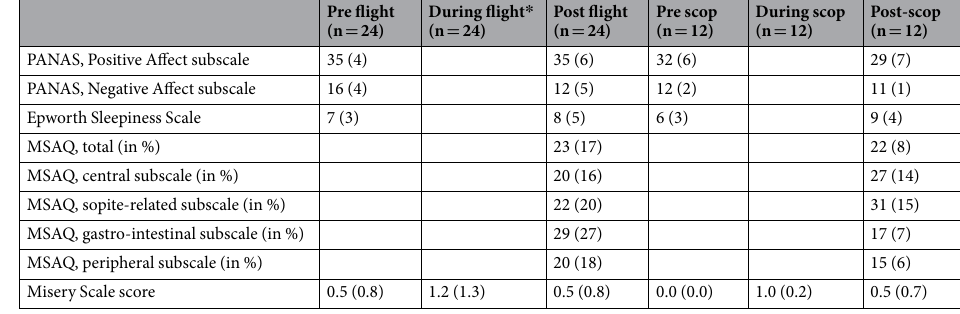
Table 1. Subjective ratings on the Positive and Negative Affect Scale, the Epworth Sleepiness questionnaire, Motion Sickness Assessment Questionnaire and Misery Scale scores (mean (SD)). MSAQ: Motion Sickness Assessment Questionnaire; PANAS: Positive and Negative Affect Scale; PF: parabolic flight; scop: scopolamine; SD: standard deviation. * Averaged over the 5 assessments during the